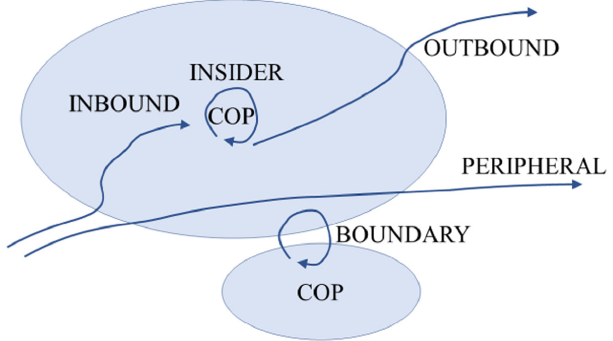
FIG. 1. Wenger conceived of several possible trajectories a learner might take in relation to a community of practice: insider trajectories (remaining central), peripheral trajectories (accessing the community without becoming a full member), inbound trajectories (peripheral-to-central), boundary trajectories (be- tween two or more COPs), and outbound trajectories (exiting the COP)